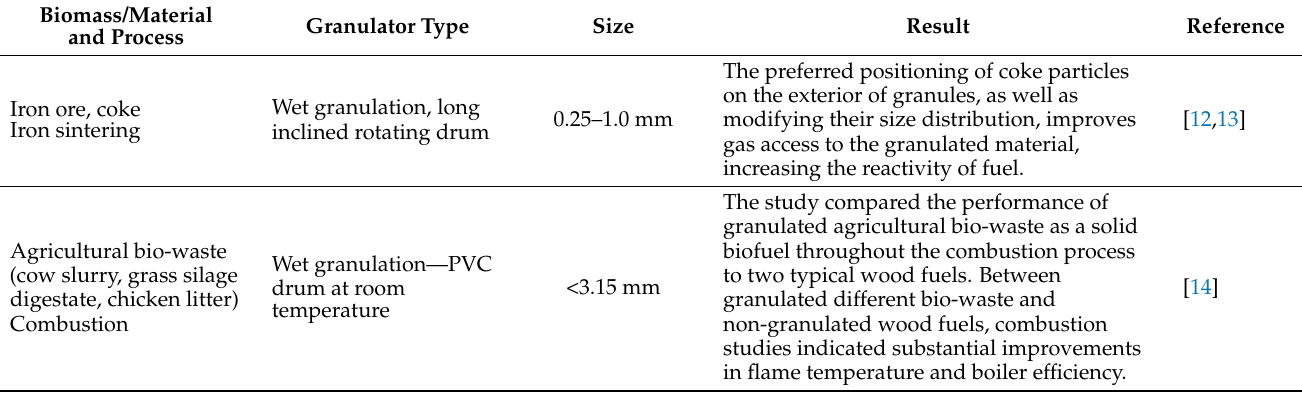
Table 1. Examples of granulation research in the literature (Web of Science Core). Biomass/Material and